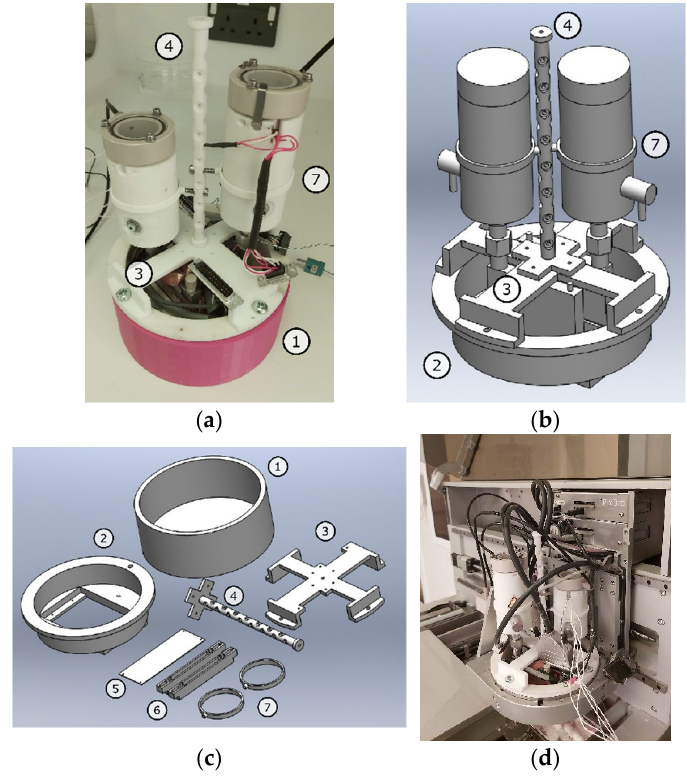
Figure 1. ( a ) Photo and ( b ) rendered image of the assembled prototype. ( c ) Rendered image display ‐ ing of the main supports parts: assembly resting holder (1), base support (2), top case (3), central anchoring structure (4), bottom cover (5), printhead holder (6), reservoir holder (7). ( d ) Close ‐ up of the dual ‐ head printing unit mounted in the LP50 printer.